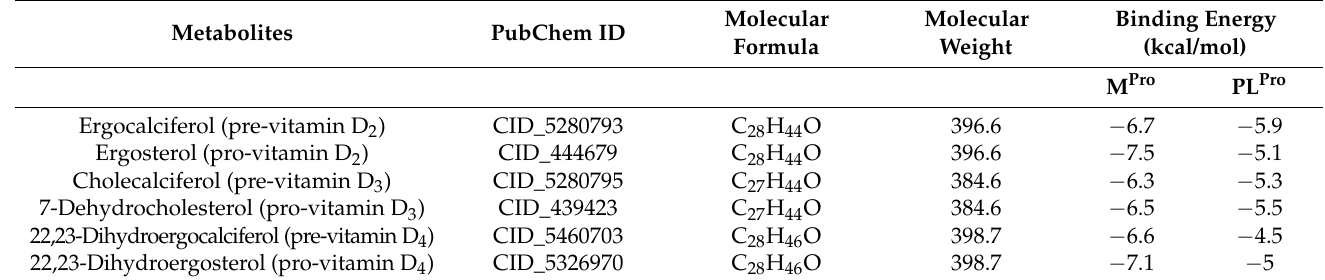
Table 1. Details of ligand molecules along with binding